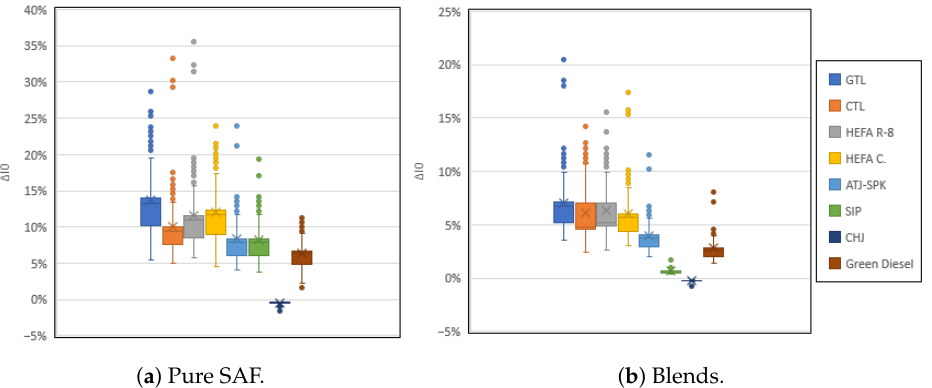
Figure 13. RDs in initial ice mass ratios for ambient relative humidities at formation of 43% or higher.